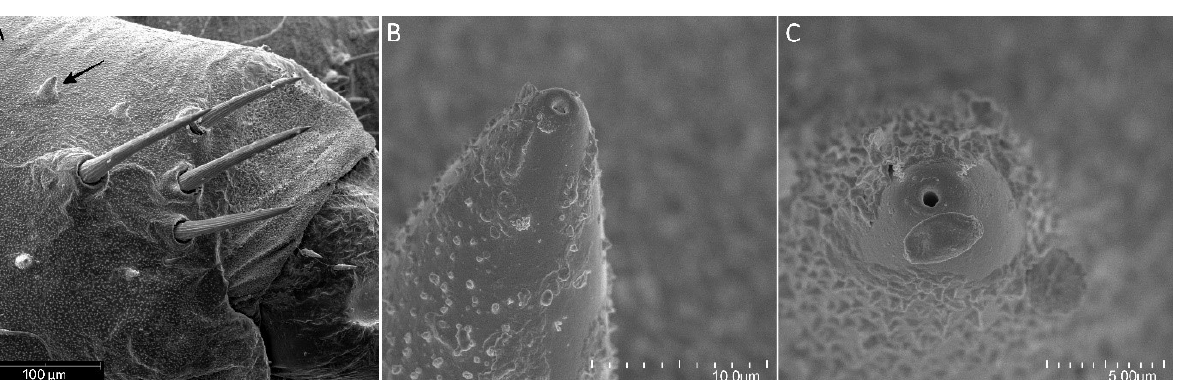
Figure 17. Psyttala horrida (Stål, 1865). ( A ) The antennal base with four trichoidea setae and small appendages [arrow]. ( B ) Magnification of the small appendage on the dorsal side of the head, thorax, and abdomen, lateral view and ( C ) dorsal view at the top with an apical pore.